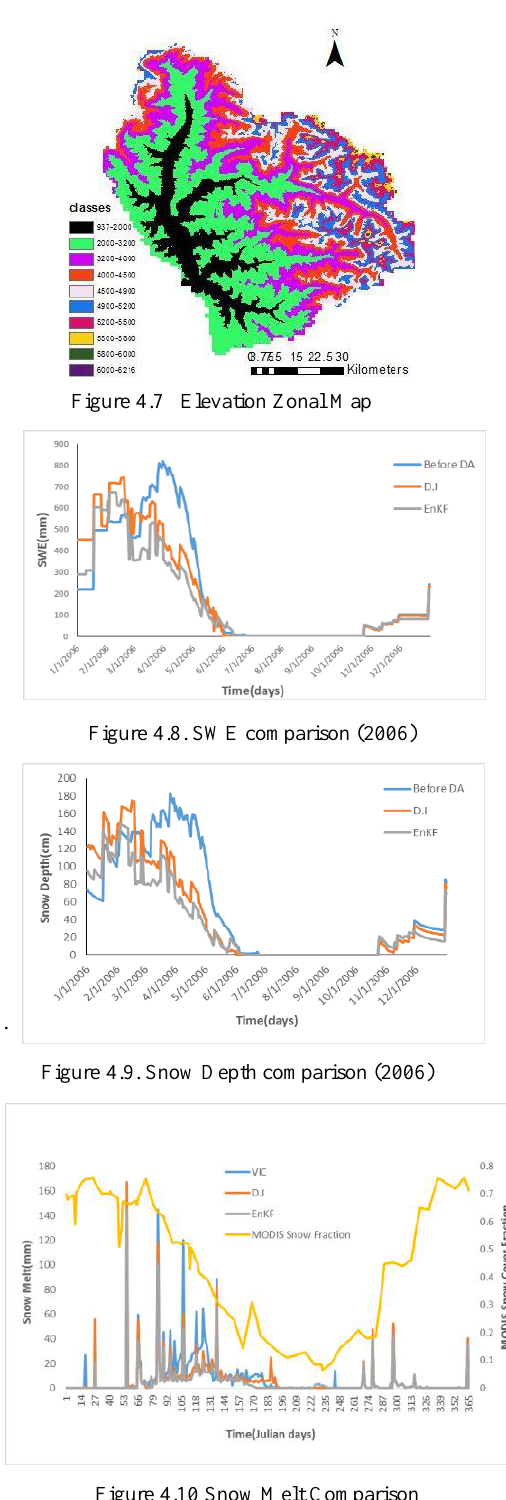
Figure 4.10 Snow Melt Comparison